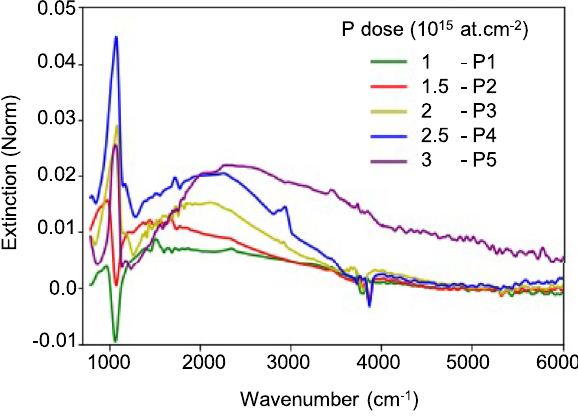
Figure 2: Normalized extinction curves measured for five different P